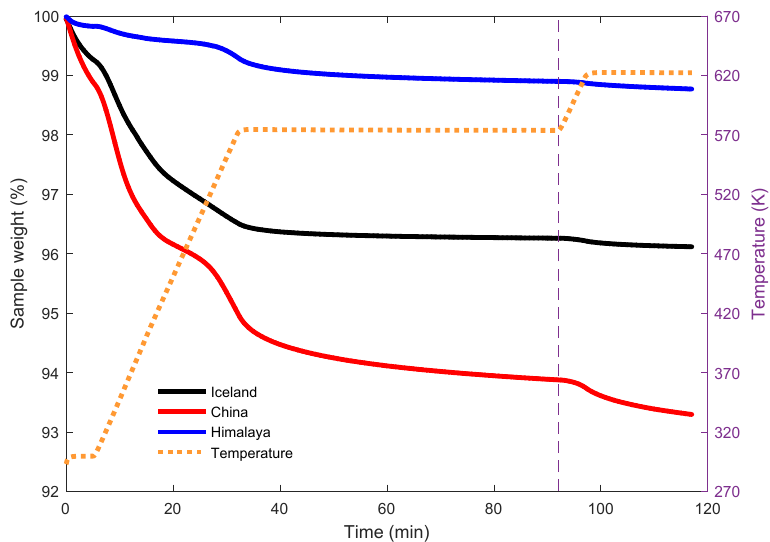
Figure 5. Results of the thermogravimetric analysis (TGA) for the three untreated dusts, showing the temporal evolution of the mass of the untreated dust samples and the temperature. For each dust the curve is an average of three measurements. The vertical grey dashed line indicates the time when the dust had been exposed to 573K for 1h and when the temperature started to increase further up to 623K.